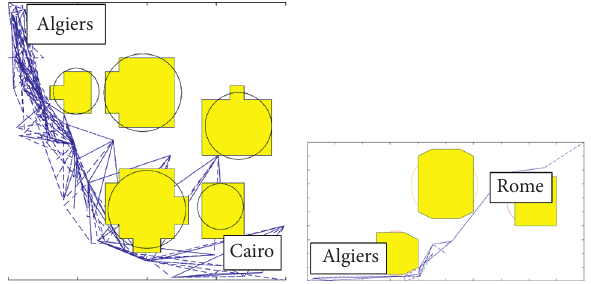
Figure 18: The searching process of genetic